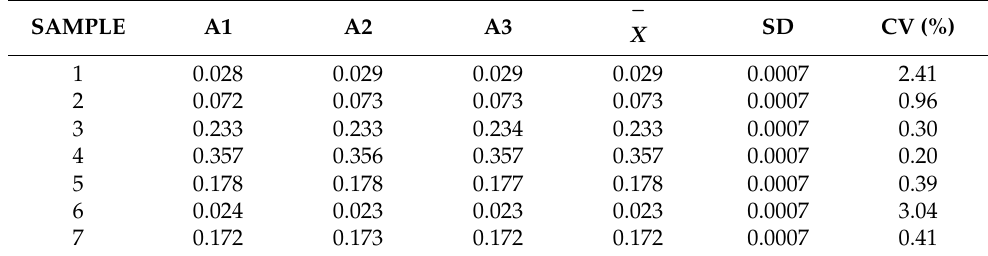
Table 5. Absorbances obtained for hydrophilic extracts of cream samples (Folin-Ciocalteu method). SAMPLE